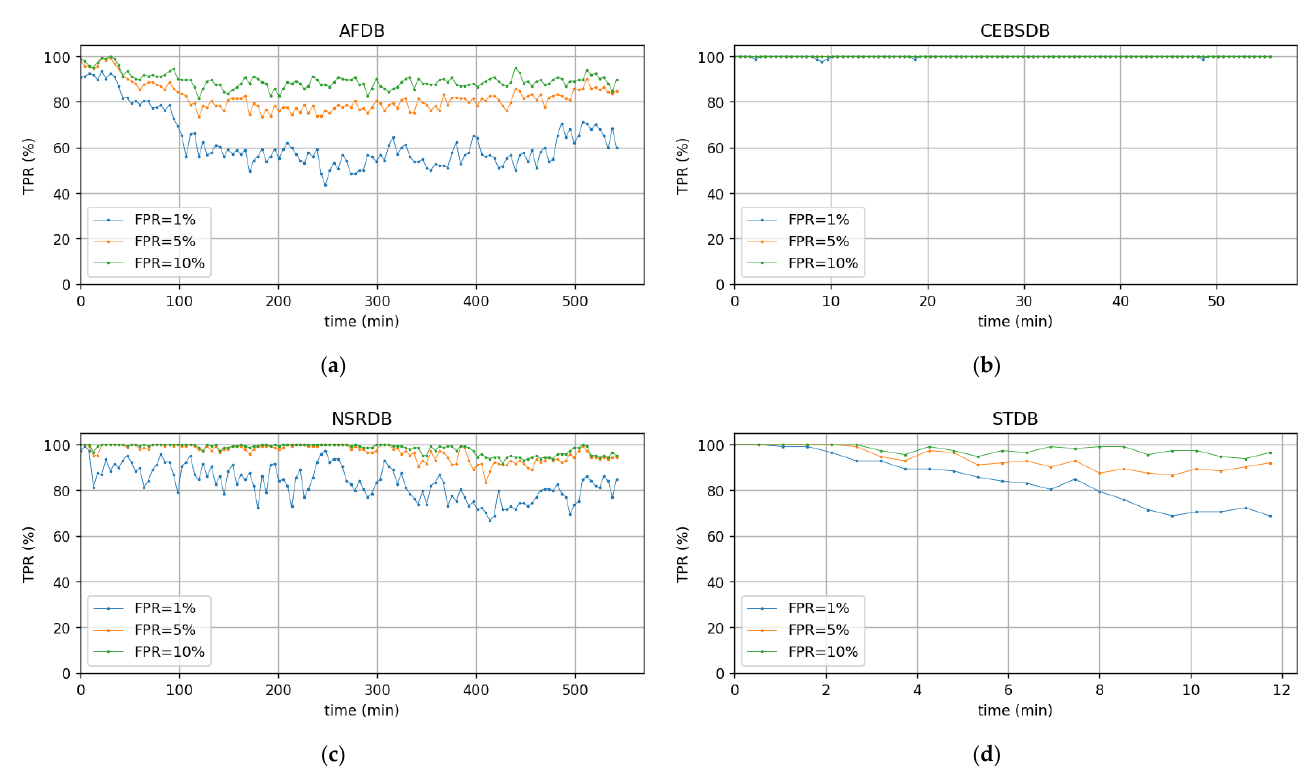
Figure A4. ROC curves are used to evaluate the scope verification performance tested over long time separation for: ( a ) ECGIDDB, ( b ) PTBDB.